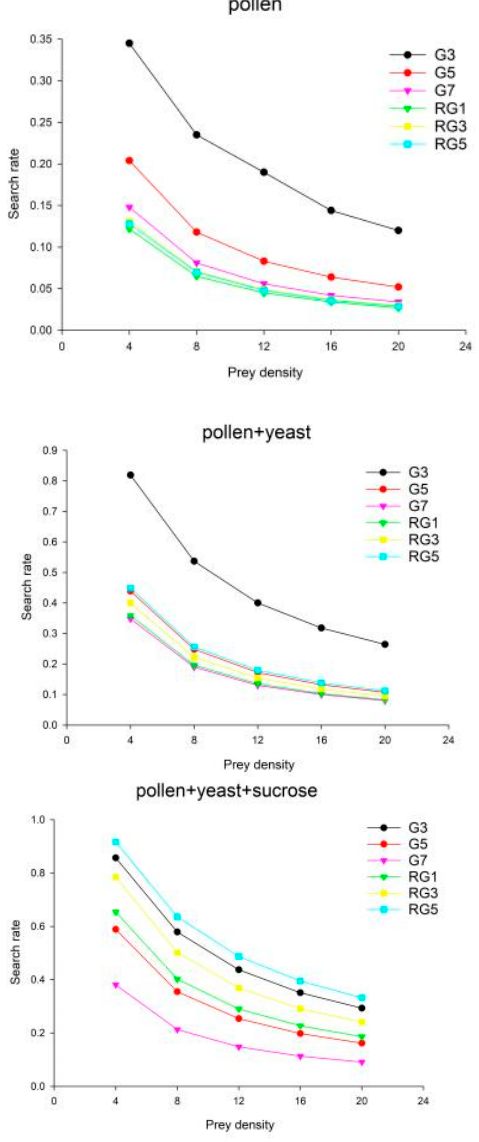
Figure 6. The search rate in the different treatment groups at different prey